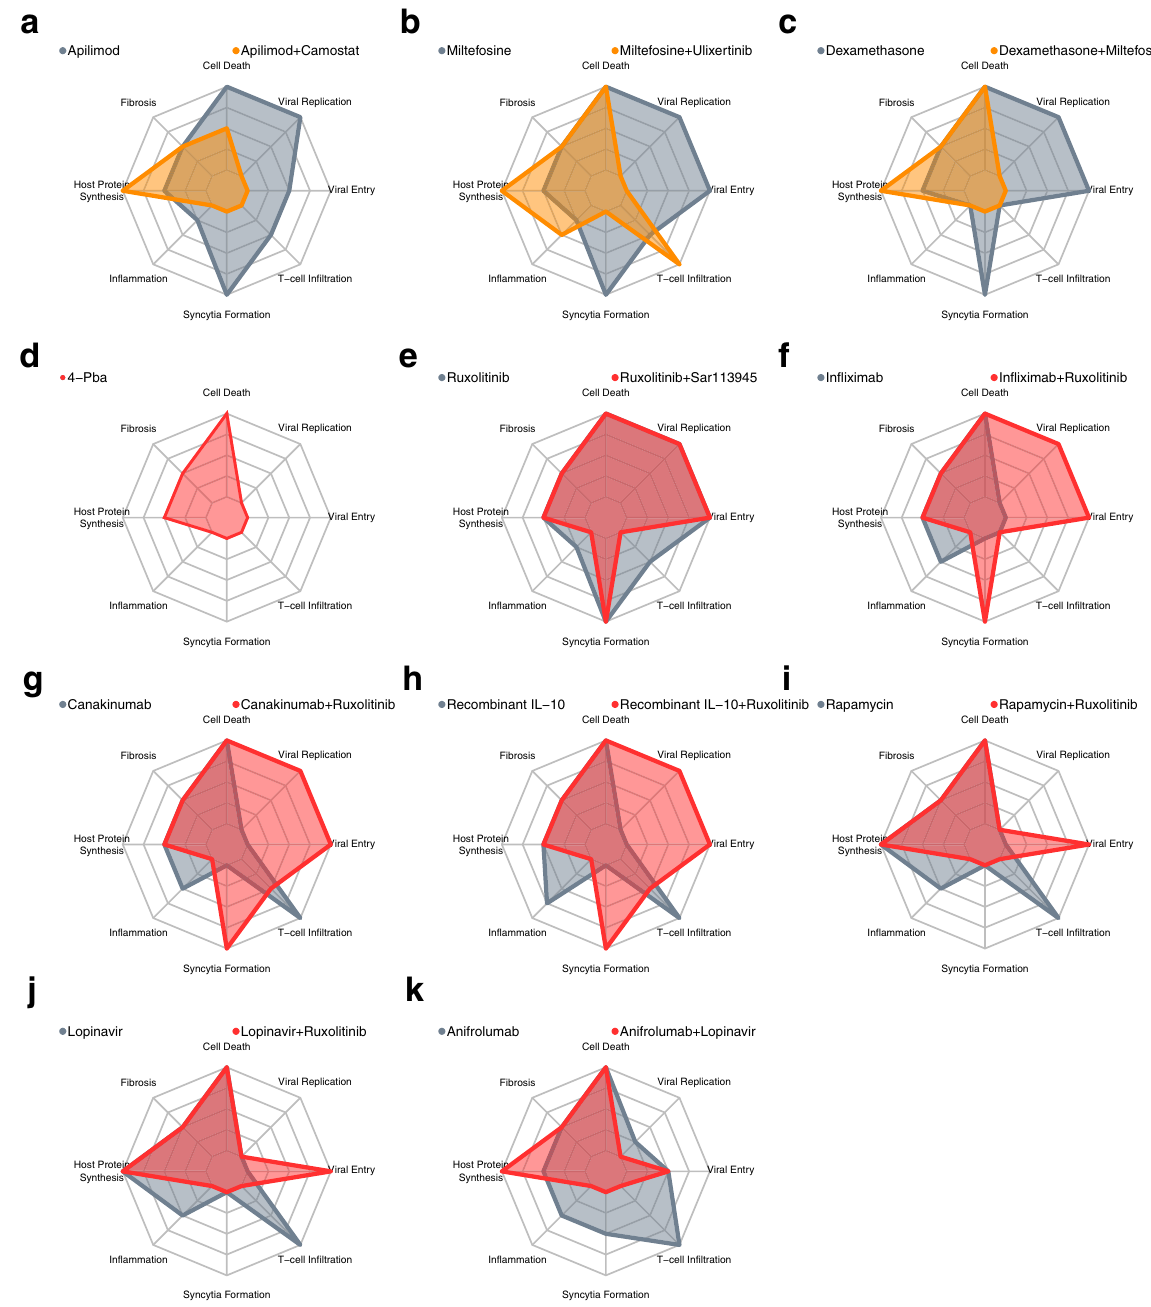
Fig. 5 Predicted effective drug treatments for severe COVID-19. a – c The effect of treatments predicted to reduce viral replication in the early stage of severe COVID-19. Recommended therapies are shown in orange, with a representative control monotherapy shown in grey, with the strength of the biological process denoted by radial distance. d – k The effect of treatments predicted to reduce viral replication in the late stage of severe COVID-19. Recommended therapies are shown in red, with a representative control monotherapy shown in grey. All nodes normalised to the maximal level of respective nodes, and range between 0 – 100%. ineffective alone such as SAR113945 (IKK inhibitor), In fl iximab impair innate immune-mediated suppression of viral entry and (TNF- α inhibitor), Canukinumab (IL-1B inhibitor) and recombinant replication in mild cases (Fig. 3f and Supplementary Fig. 2g, h), IL-10 (Figs. 4c, d, 5e – j). and has no bene fi t in early severe disease (Fig. 3f and The trade-off of these combinations suggests that they should Supplementary Fig. 3d). While our model does not suggest be used only in the late stage of the disease. For example, a combination treatments that can ameliorate this, meaning that combination of Rapamycin and Ruxolitinib is predicted to be more Ruxolitinib is likely too risky to use in mild disease, we predict effective against in fl ammation than either drug alone. However, several ways to enhance the effects of Ruxolitinib appropriate for together these drugs are also predicted to increase viral entry (Fig. 5i). the late stage of severe disease. These include drugs that are npj Digital Medicine (2022)